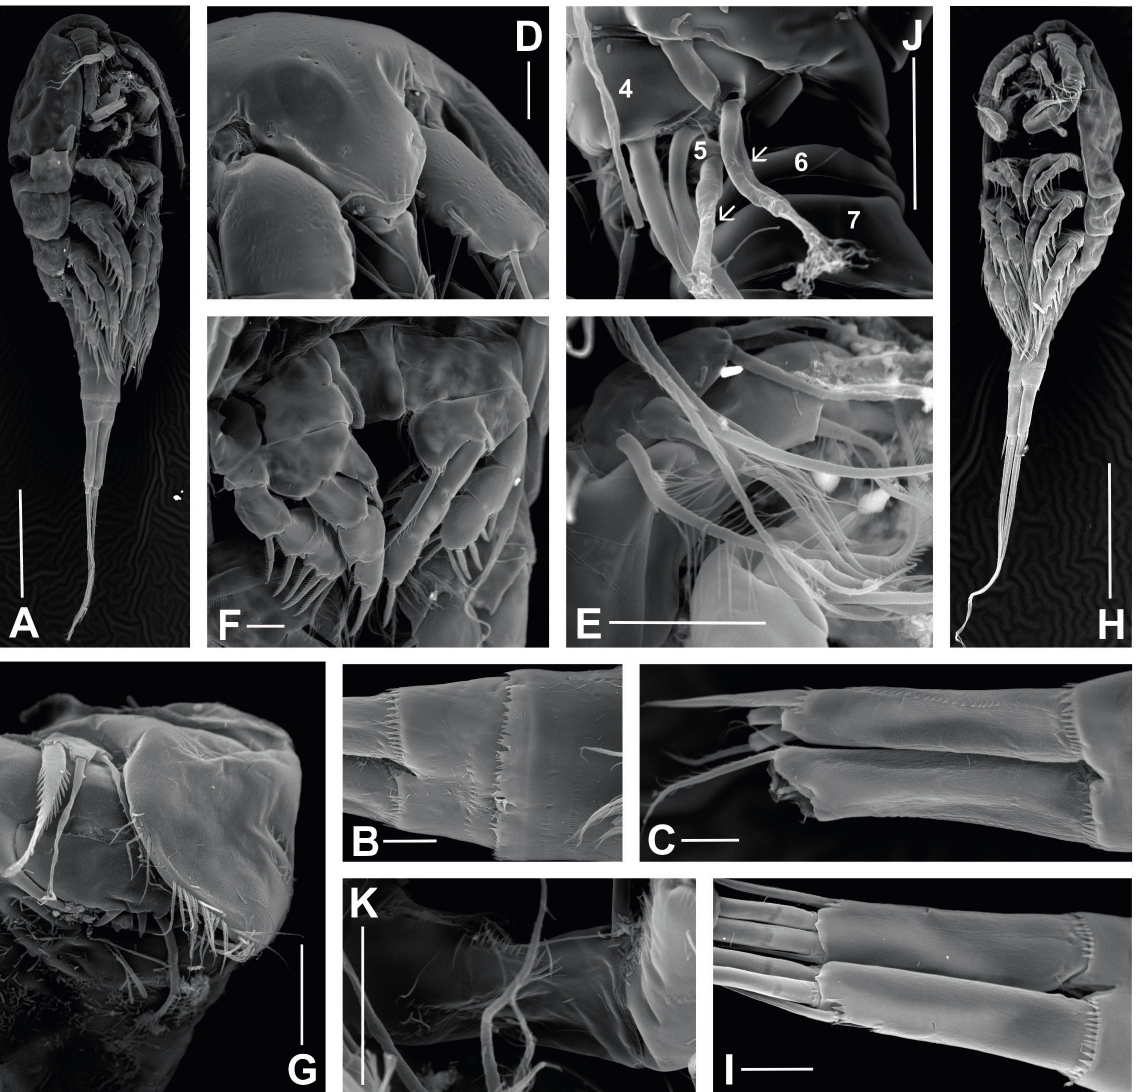
Fig. 1. Eucyclops azorensis Defaye & Dussart, 1991 (Algeria, Ain-Kemellal; MIZ), SEM micrographs. A−G . ♀. H−K . ♂. A . Habitus, lateroventral view. B . Last two urosomal somites, ventral view – note the integumental ornamentation of shallow pits. C . Caudal rami, ventral view. D . Rostrum area of the cephalothorax and first antennulary segments. E . Maxillulary palp. F . Leg 1, frontal view. G . Leg 5 and leg 6. H . Habitus, ventral view. I . Caudal rami, ventral view – note the lack of ʻSerraʼ on the lateral margin. J . Antennule, modified setae indicated by arrows on segments 4 and 5. K . Antennal coxobasis, frontal view. A–B, E show ♀-2; C–D, F show ♀-1; G shows ♀-3; H–I show ♂-2; J shows ♂-1; K shows ♂-3. Scale bars: A, H = 200 μm; B−G, I−K = 20